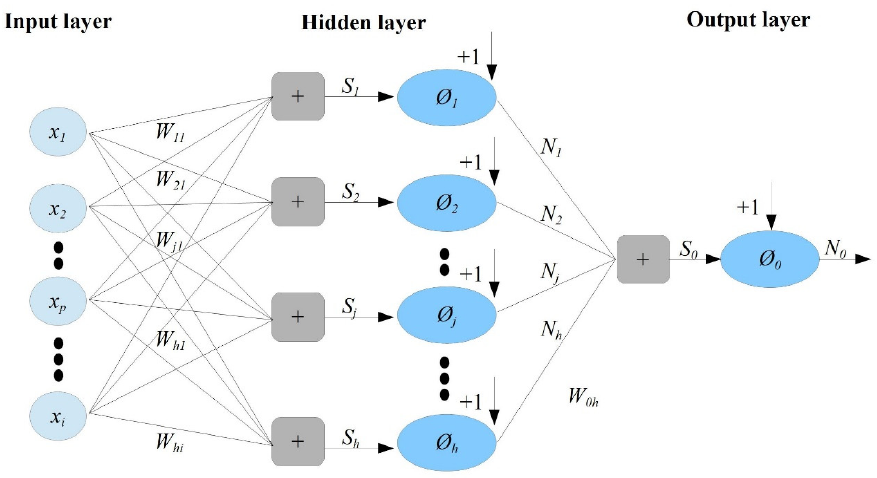
Figure 2. The structure of the FFNN.